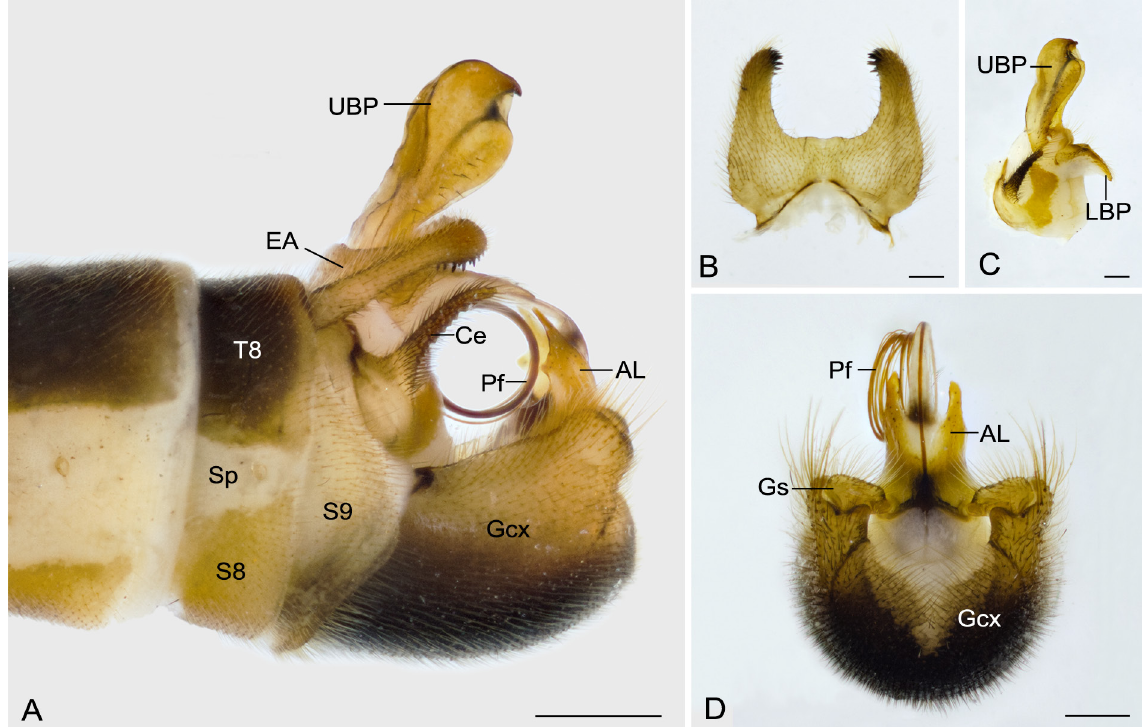
Fig. 7. Male genitalia of Terrobittacus angustus sp. nov. A . Terminalia in lateral view. B . Epandrial appendages in dorsal view. C . Abdominal segment X and proctiger in lateral view. D . Genitalia in caudal view. Abbreviations: AL = aedeagal lobe; Ce = cercus; EA = epandrial appendage; Gcx = gonocoxite; Gs = gonostylus; LBP = lower branch of proctiger; Pf = penisfilum; S = sternum; Sp = spiracle; T = tergum; UBP = upper branch of proctiger. Scale bars: A = 0.5 mm; B–D = 0.2 mm.